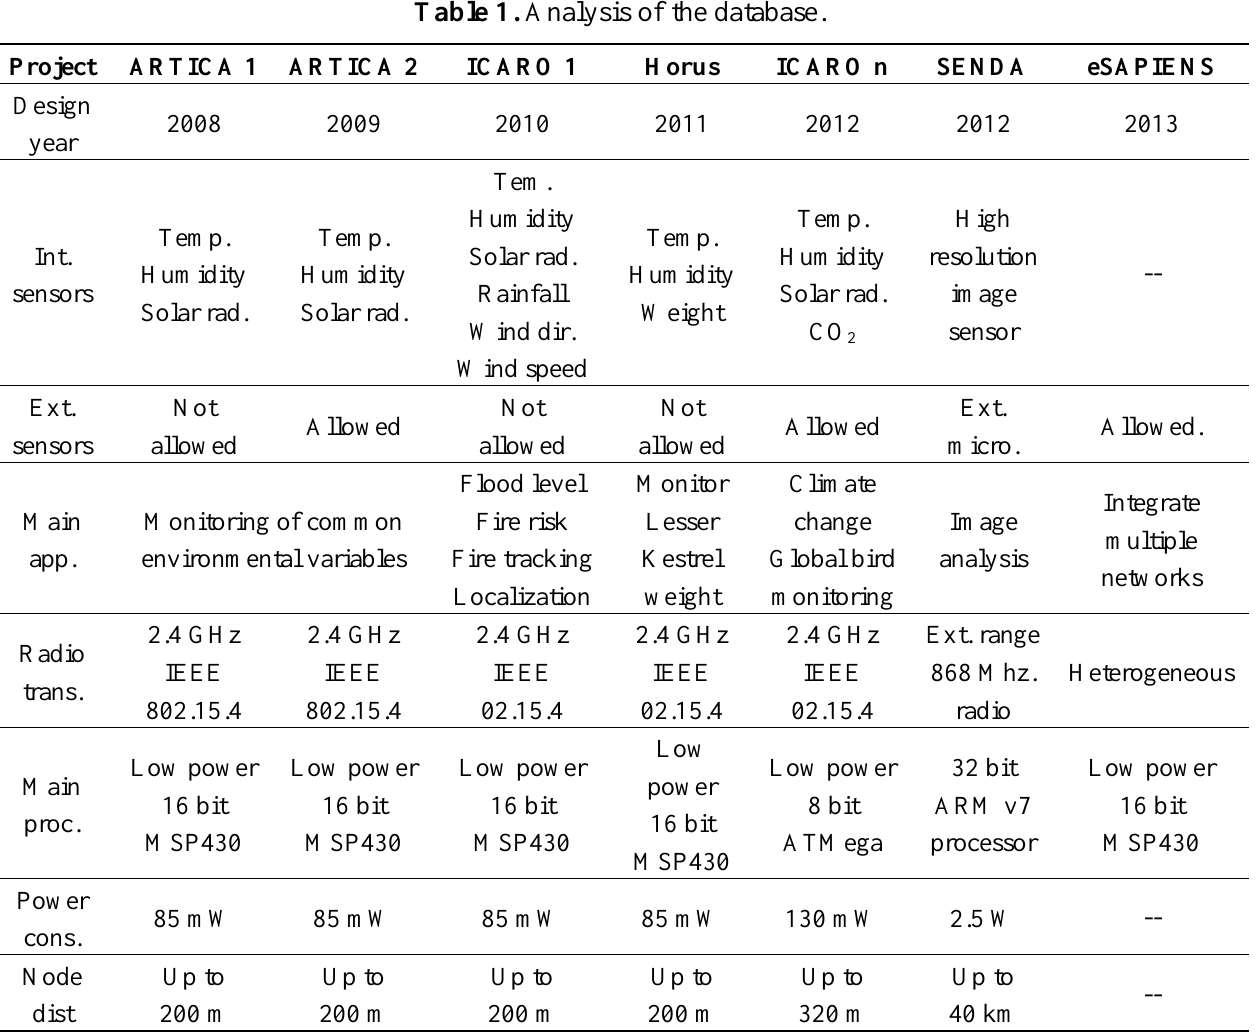
Table 1. Analysis of the